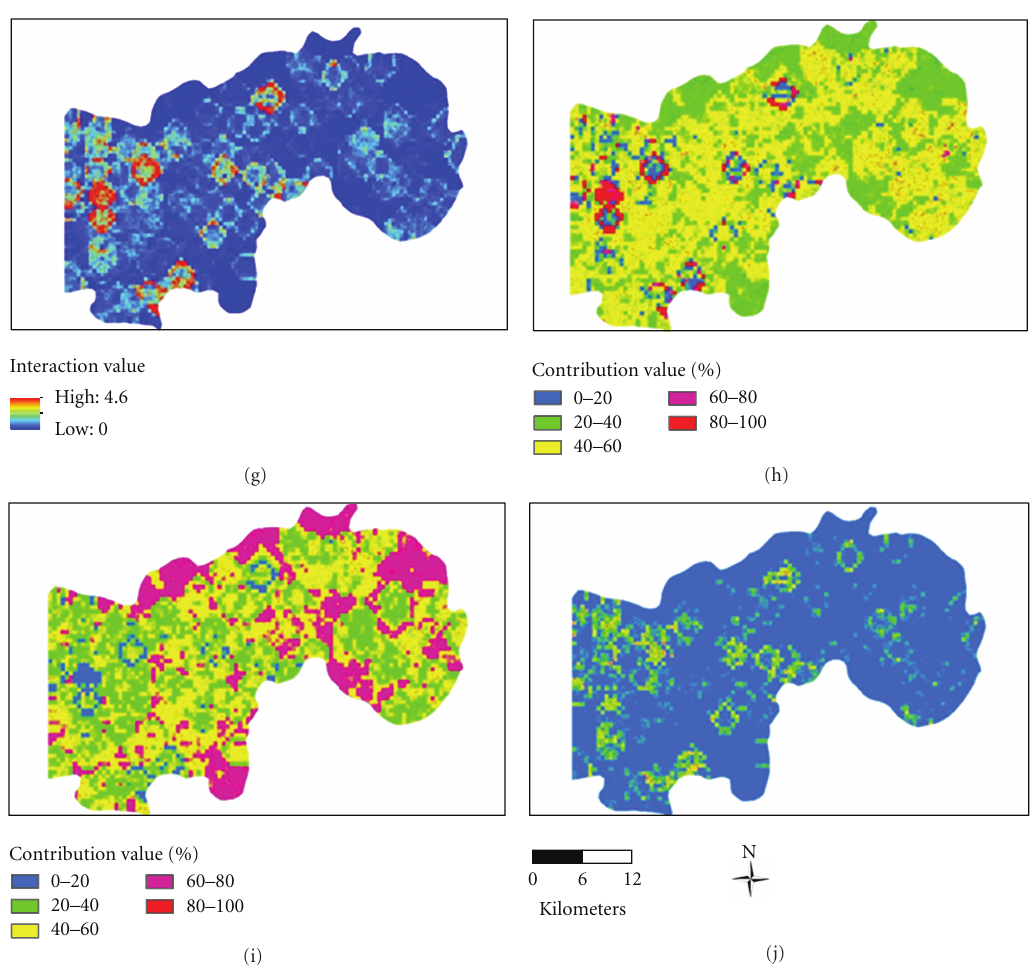
Figure 5: Aboveground forest carbon map obtained by combining forest inventory sample plot data and ETM+ images using image-based spatial co-simulation and its polynomial regression-based uncertainty analysis in Lin-An county, Zhejiang province of East China. [(a) forest carbon (T/ha) of sample plots used for development of algorithm; (b) forest carbon (T/ha) of sample plots used for test of results; (c) predicted forest carbon values (T/ha); (d) errors (T/ha) of predicted forest carbon values; (e) variance of input plot data; (f) variance of input image; (g) interaction of forest carbon and image variances; relative uncertainty contribution (%) from (h) the input plot data, (i) ETM+ image, and (j) their